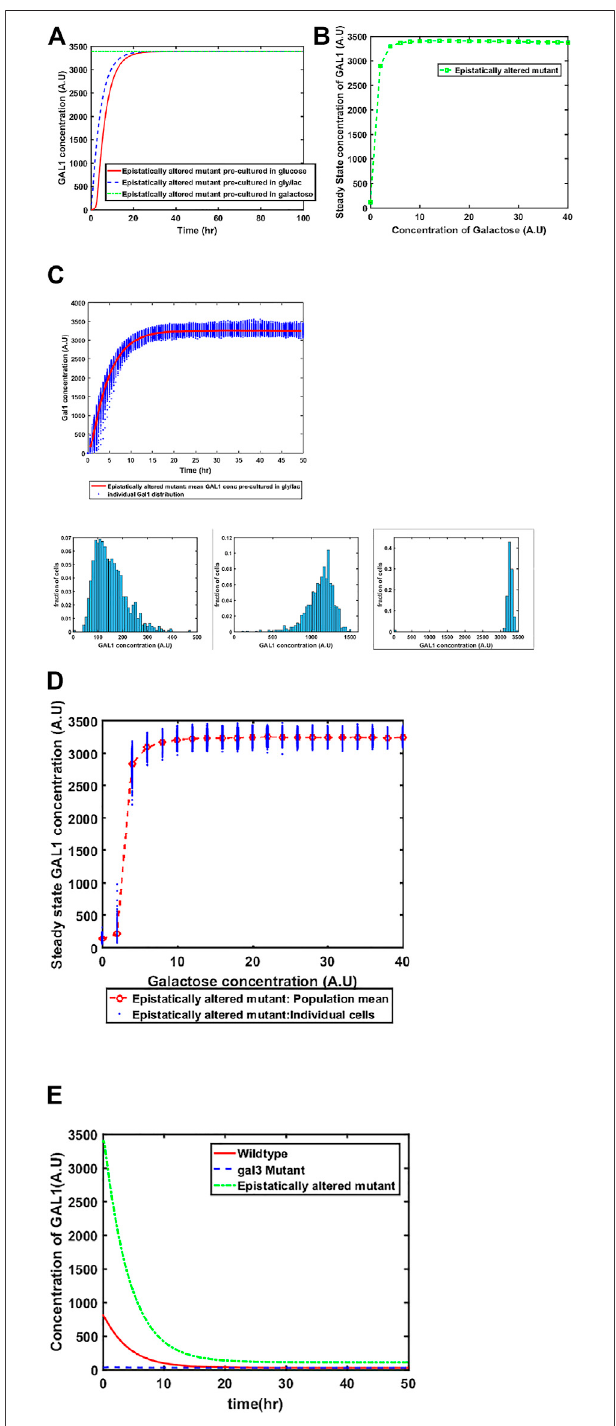
FIGURE 4 | Dynamics of gene expression for the epistatically-altered strain. (A) Activation of GAL network in galactose [concentration, 30 (A.U)]. FIGURE 4 | present. (C) Dynamic GAL1 response at galactose concentration GAL1 pro fi le when cells are pre-cultured in gly/lac (dashed blue line), glucose of30(A.U)for1000cellspre-growningly/lac.HistogramsofGAL1expression (solid red line), and galactose (dashed green line). (B) Steady state at 30 min, 5 h, and 50 h. (D) Steady state concentration of GAL1 under concentration of GAL1 protein at different concentrations of galactose. Note differentconcentrationofgalactose. (E) ThedynamicsoftransitionfromONto that the system exhibits a behaviour which is qualitatively different than the OFF state in the ancestor and the epistatically altered strain. Note that even wild type behavior. The threshold of galactose concentration is no longer after long times, the epistatically altered strain has a non-zero residual GAL1 ( Continued ) expression. The GAL1 pro fi le for the gal3 Δ is shown as